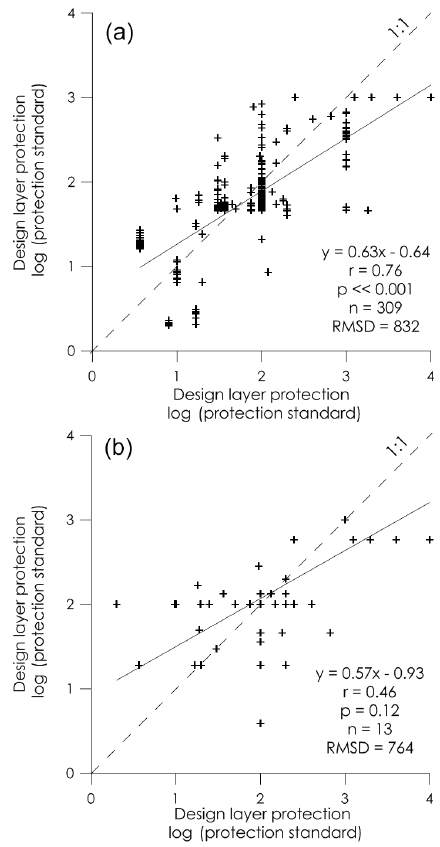
Figure 5. Correlation between data sets of (a) the design and of the model layers, and (b) the design and the policy layers. A log- transformation was applied to the protection standard values ex- pressed as return periods. The slope and intercept of the regression curves are shown, along with the r Pearson’s correlation coefficient (with the p value of the correlation) and the root-mean-square de- viation (RMSD). When a minimum and maximum protection value were present, the average of the annual exceedance probabilities (the inverse of the return period) was